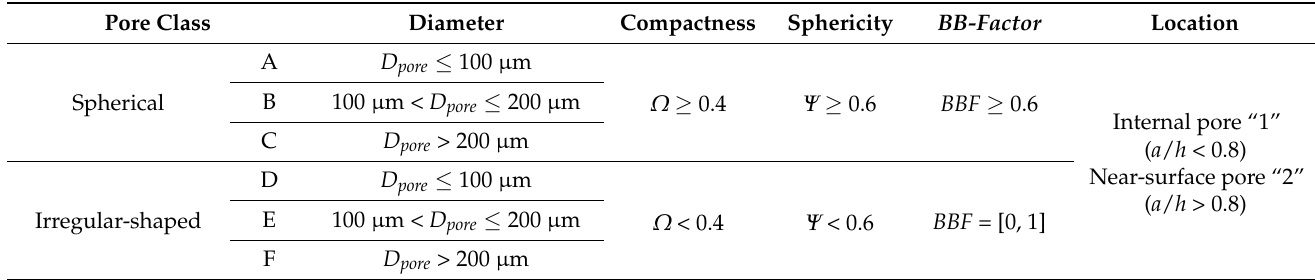
Table 2. Pore classification criteria using X-ray